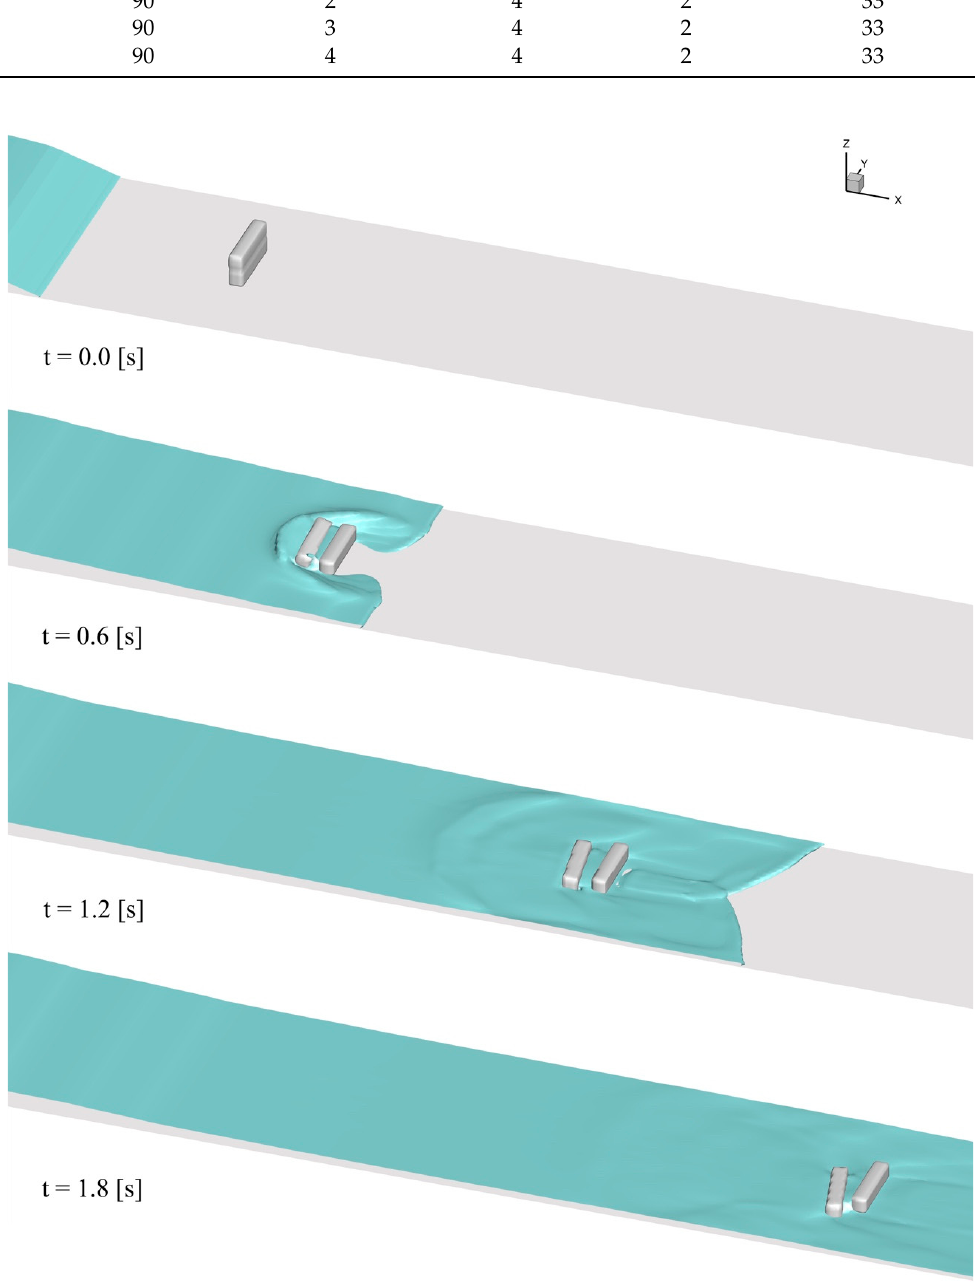
Figure 7. Snapshot of Configuration 11290 displacements in the x direction after starting the drift at 0.6 s